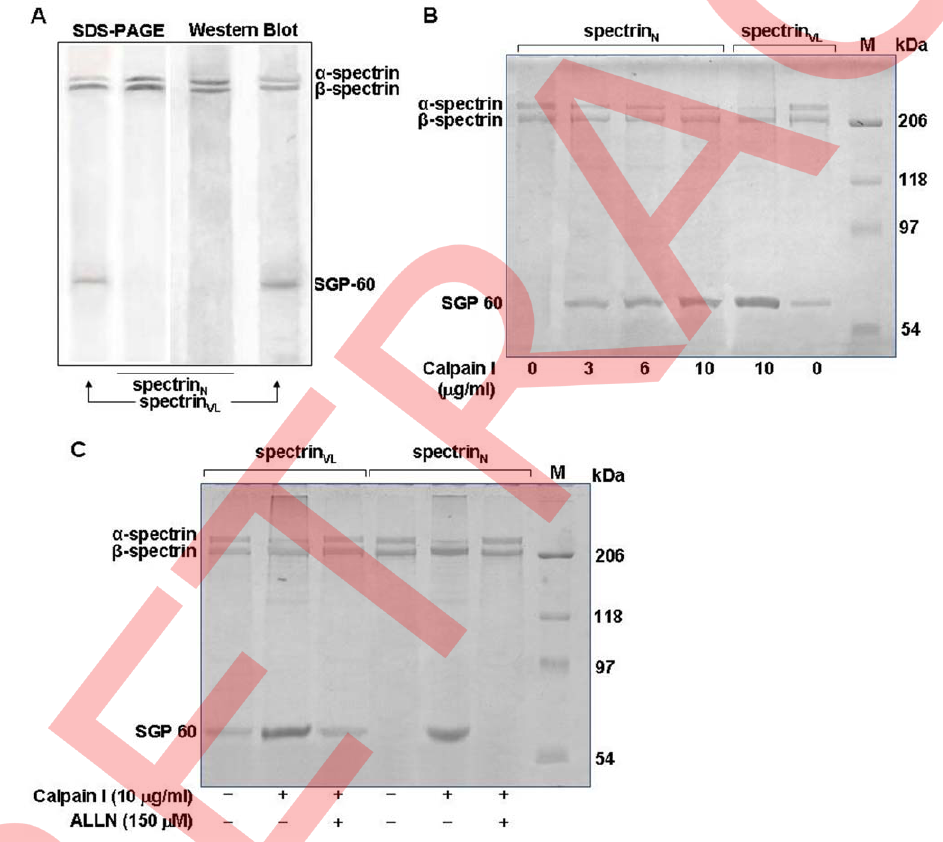
Figure 5. Degradation of purified a -spectrin by activated calpain I. A. Characterization of purified spectrins . Spectrin VL and spectrin N were purified from RBC VL and RBC N as described in Materials and Methods, and analyzed on SDS-PAGE (7.5%). The purified spectrins were Western blotted and detected with polyclonal rabbit anti-spectrin antibodies. B. Proteolysis of purified spectrin VL and spectrin N by active calpain I . Spectrin N and Spectrin VL (3.0 m g) were digested with different doses of active calpain I as indicated in reaction buffer, the reaction was stopped with EGTA and the products analyzed by SDS-PAGE. C. Inhibition of proteolysis by the calpain I inhibitor ALLN . Calpain I was preincubated with ALLN for 15 min on ice prior to addition of reaction buffer containing purified spectrin VL or spectrin N and processed as before.